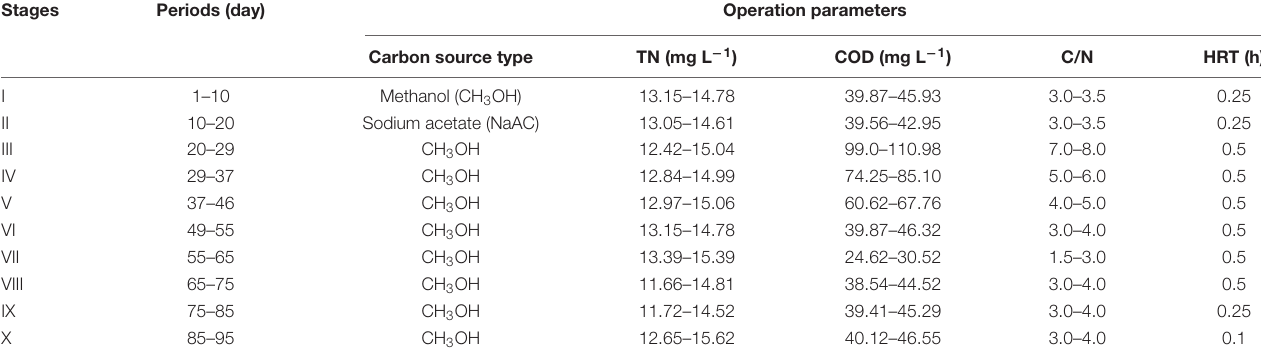
TABLE 2 | Operation parameters of different